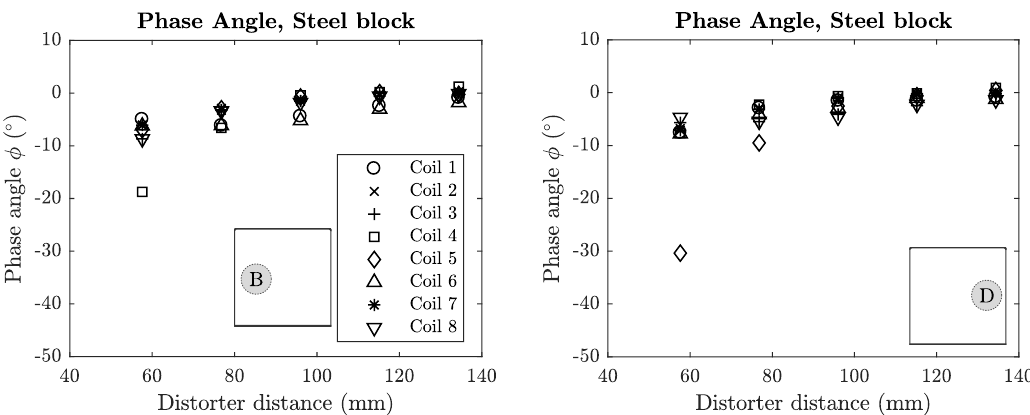
Figure A7. Phase error plots for small steel block distorter in locations B and D. The largest errors are experienced by coils 4 and 5 in closest proximity to locations B and D respectively. Negative phase error is experienced in both